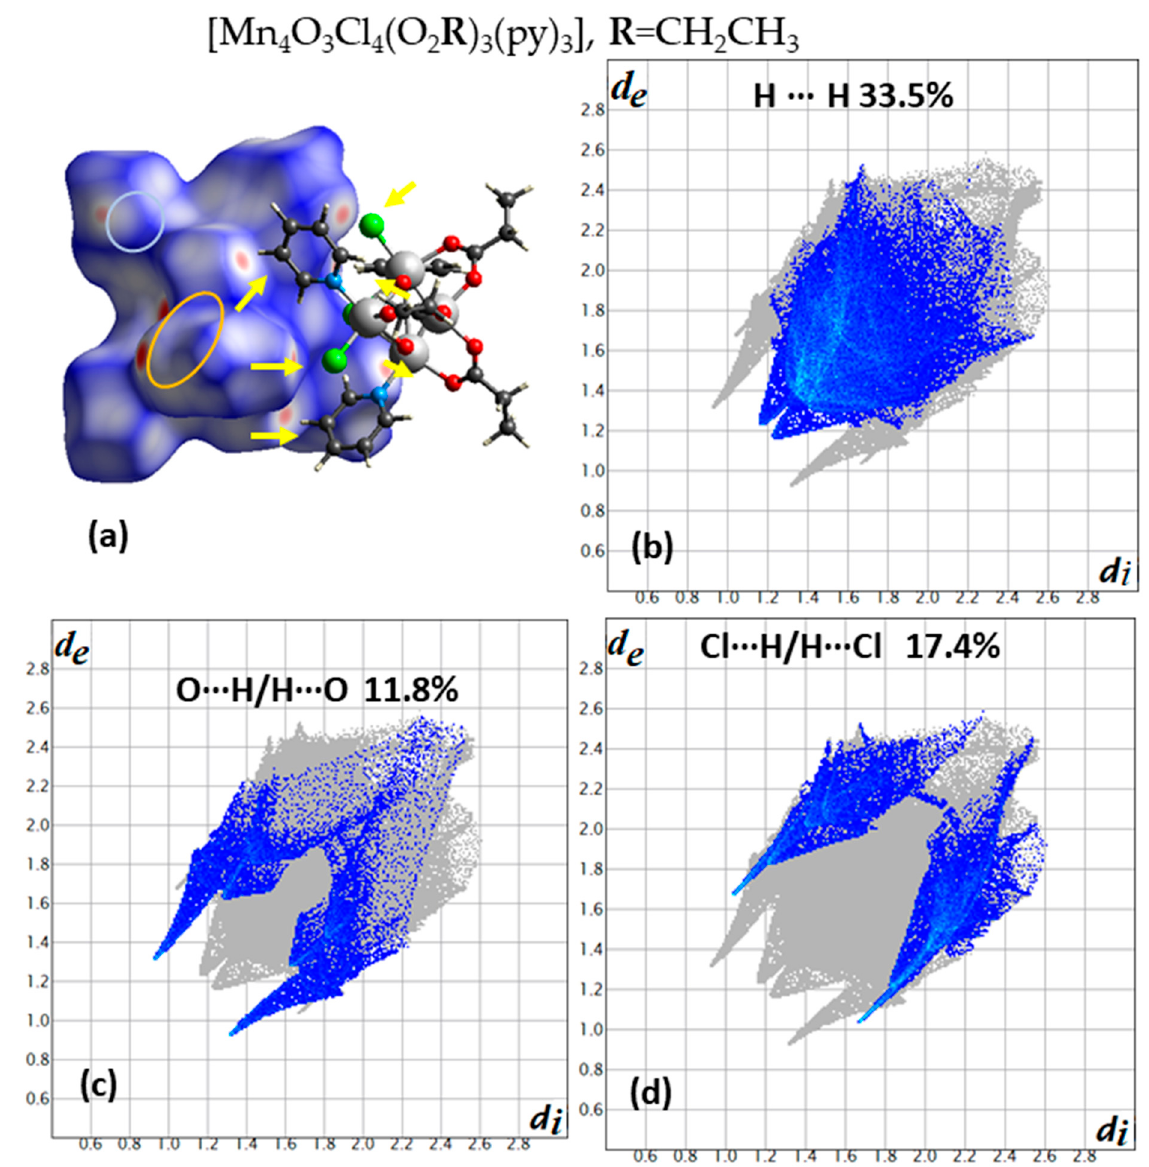
Figure 1. ( a ) A dimer of complexes with one molecule to be surrounded with a d norm decorated HS and the other in a ball and stick presentation for compound 1 . The six orange vectors indicate the six contact points of Cl ∙∙∙ H type of interactions. The red areas in the orange and cyan ellipses indicate O ∙∙∙ H and C ∙∙∙ H contact points. Contribution of each type of interactions ( b ) H ∙∙∙ H, ( c ) O ∙∙∙ H/H ∙∙∙ O, and ( d ) Cl ∙∙∙ H/H ∙∙∙ Cl derived from the fingerprint plot of compound 1. The outline of the full fingerprint contribution is shown in gray.